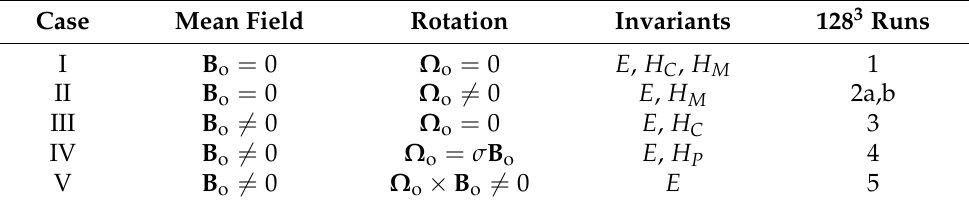
Table 1. Cases and associated Runs with different integral invariants for ideal MHD turbulence. The σ H M and occurs when Ω o = σ B o , i.e., Ω o is parallel to B o . ‘parallel helicity’ of Case IV is H P = H C − Case Mean Field Rotation Invariants 128 3 Runs I B o =